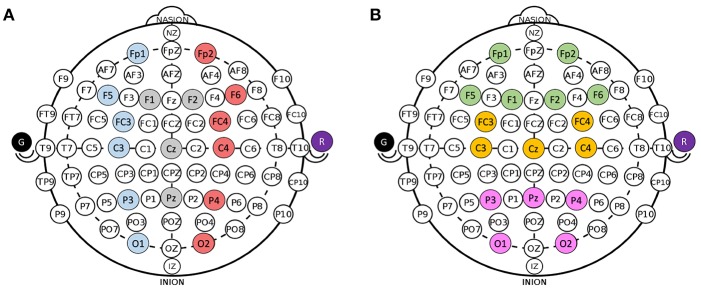
Groupings for electrodes. (A) Divisions for Left (blue), Center (gray), and Right (red) electrodes. (B) Divisions for Front (green), M (yellow), and Back (pink) electrodes. Ground (black) and Reference (purple) are collected from ear clip electrodes.